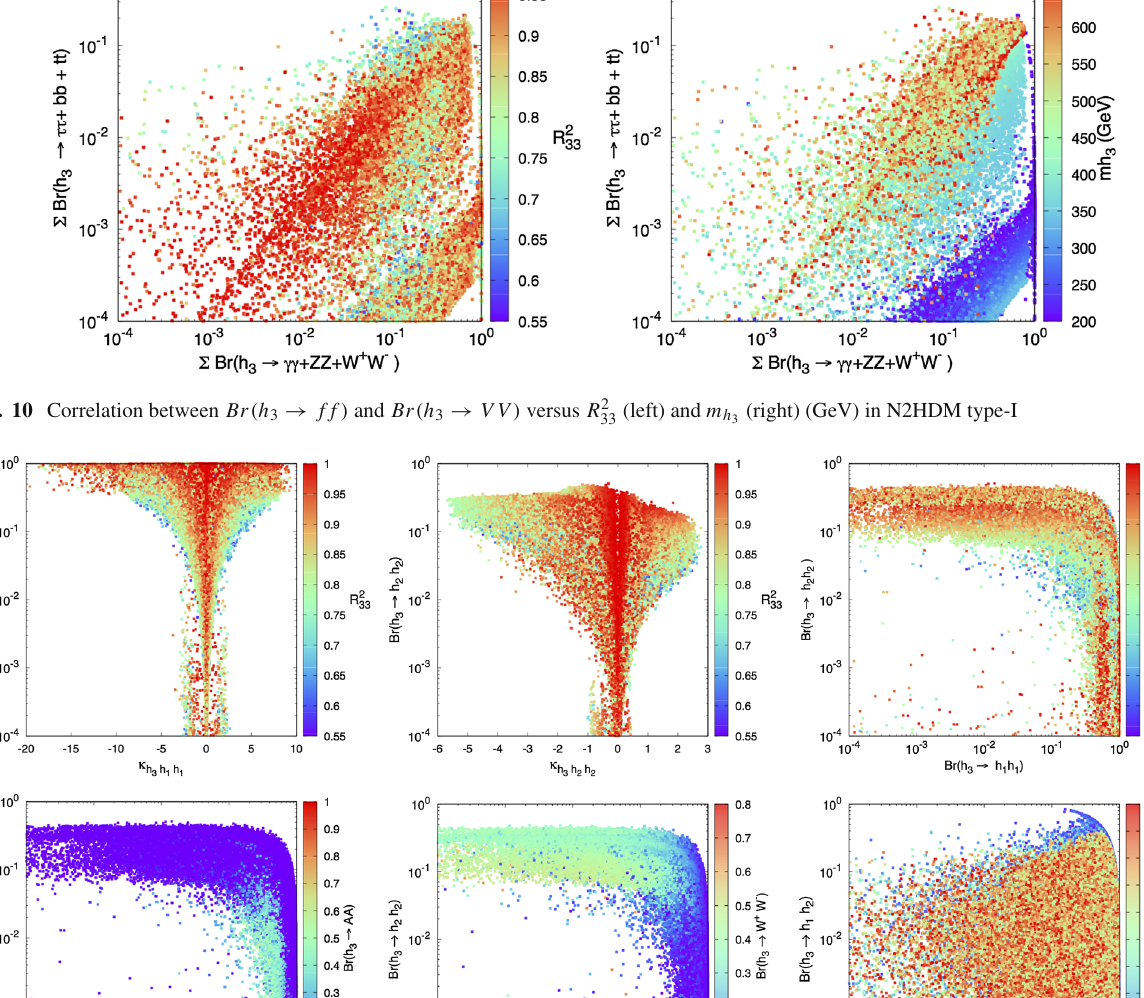
Fig. 11 Upper panels: (left) Br ( h 3 → h 1 h 1 ) as a function of κ h and (middle) Br ( h 3 → h 2 h 2 ) as a function of κ h played on the vertical and (right) the correlation between Br ( h 3 → h 1 h 1 ) and Br ( h 3 → h 2 h 2 ) . Lower panels: correlation between